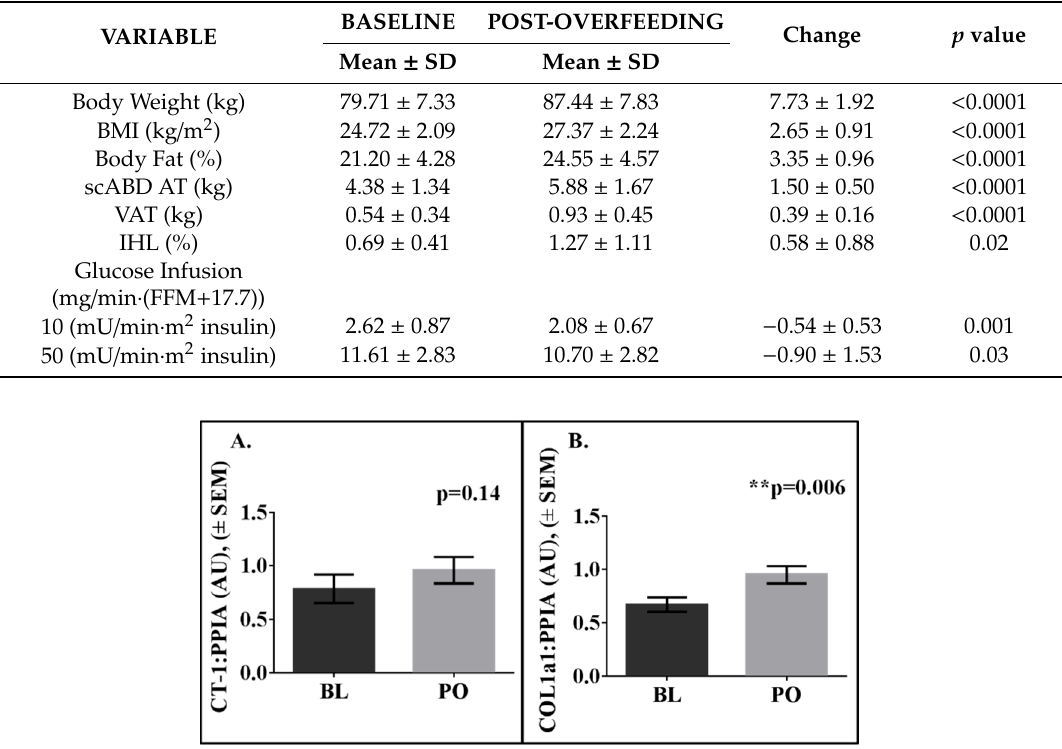
Table 2. Clinical Changes with Overfeeding ( N = 15).